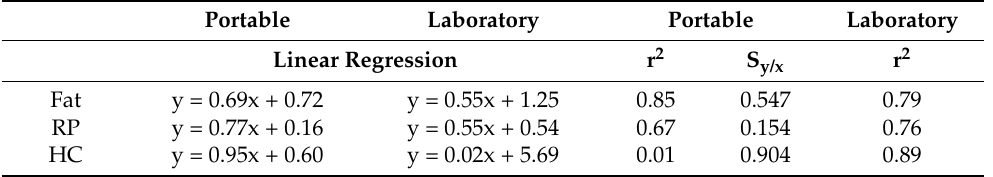
Table 5. Comparison of external validation statistics: Ref. [28] (laboratory instrument) vs. the proposed methodology (portable